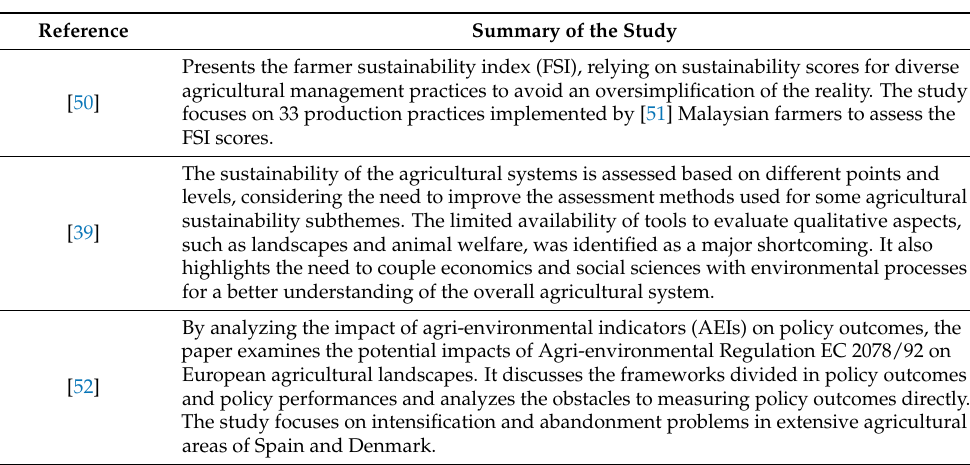
Table 1. Most relevant papers on sustainability providing relevant information on the indicators and their relevance for case study applications and different conditions. The papers in relation to the frameworks considered in this manuscript are not reported, except those comparing different